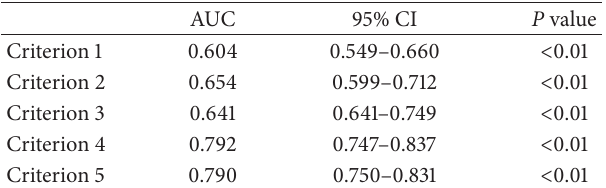
Table 5: Outcomes of area under the receiver operating character- istic analysis of the five biopsy